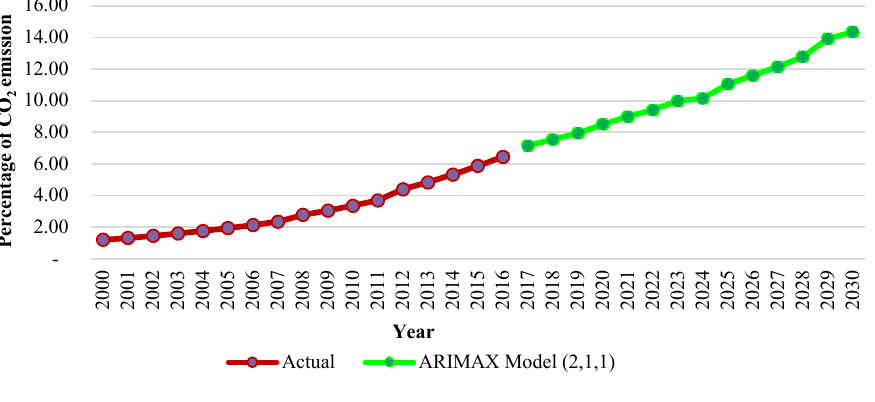
Fig. 2. Forecasting from ARIMAX Model 1 (2,1,1).